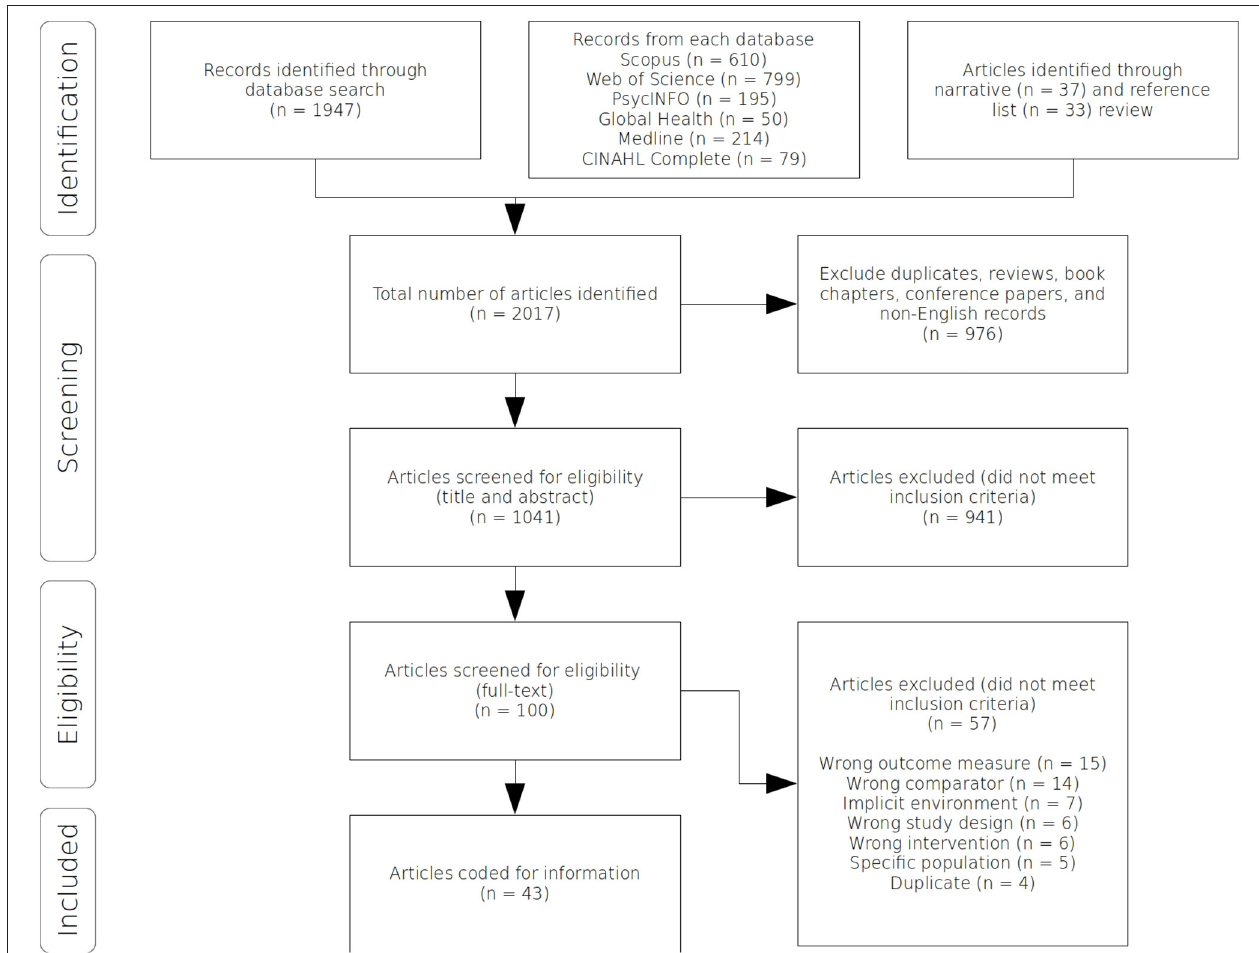
FIGURE 1 | Flow diagram of the systematic review